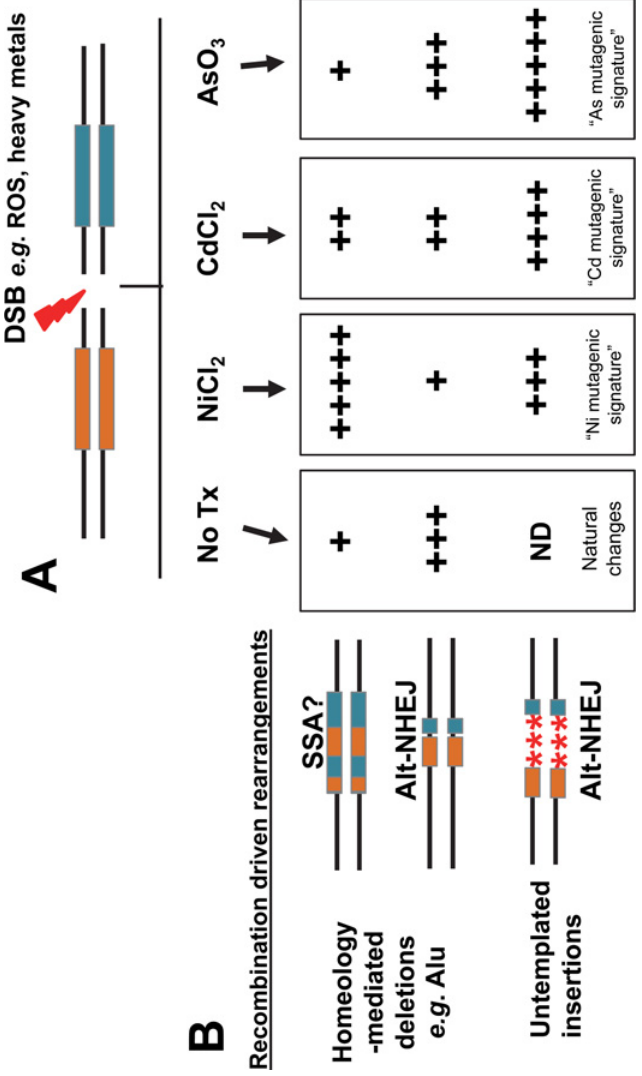
Fig 6. Role of heavy metals as promotors of genetic instability through the accumulation of genetic damage by favoring error-prone DNA repair. A. DSBs are consistently occurring in cells either as a byproduct of natural processes or due to external insults such as heavy metal exposure. DSBs near repetitive sequences, such as Alu elements (shown as orange and blue boxes) will result in different repair outcomes usually with one type being favored. B. When compared to an untreated control (no Tx), our data show that exposure to different heavy metals can differentially alter the choice between pathways to promote error- prone repair by favoring spontaneous recombination between repeat sequences ( e . g .Alu); homeology- mediated deletions which occur through the NAR or Alt-NHEJ repair; and untemplated insertions during repair by alt-NHEJ. The proportion of the different types of repair outcomes varies between the different heavy metal treatments. The overall effect of heavy metal exposure will favor the accumulation of specific genomic changes and loss of genomic sequence contributing to signature mutagenic changes as a manifestation of the exposure. ND = not